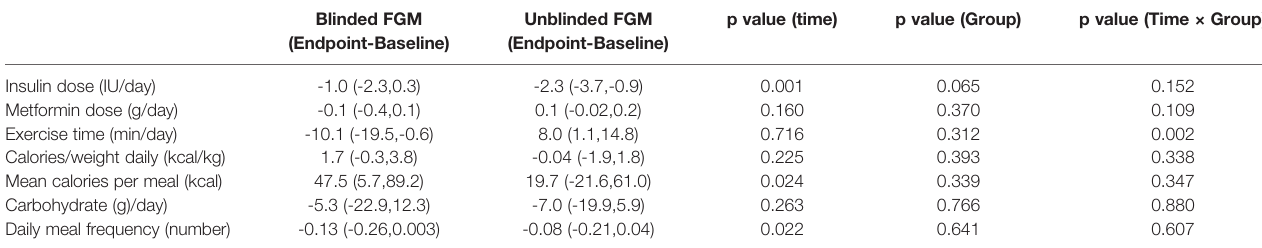
TABLE 3 | Changes of medications, and lifestyles from baseline to